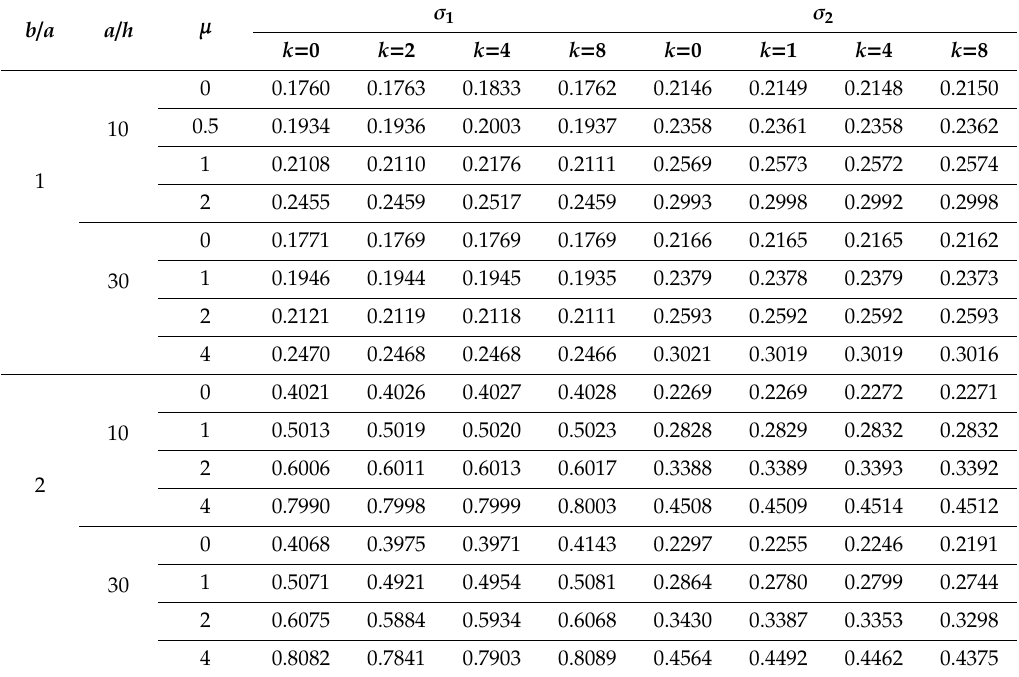
Table 4. The non-dimensional in plane stresses in an FG nano-scale plate.